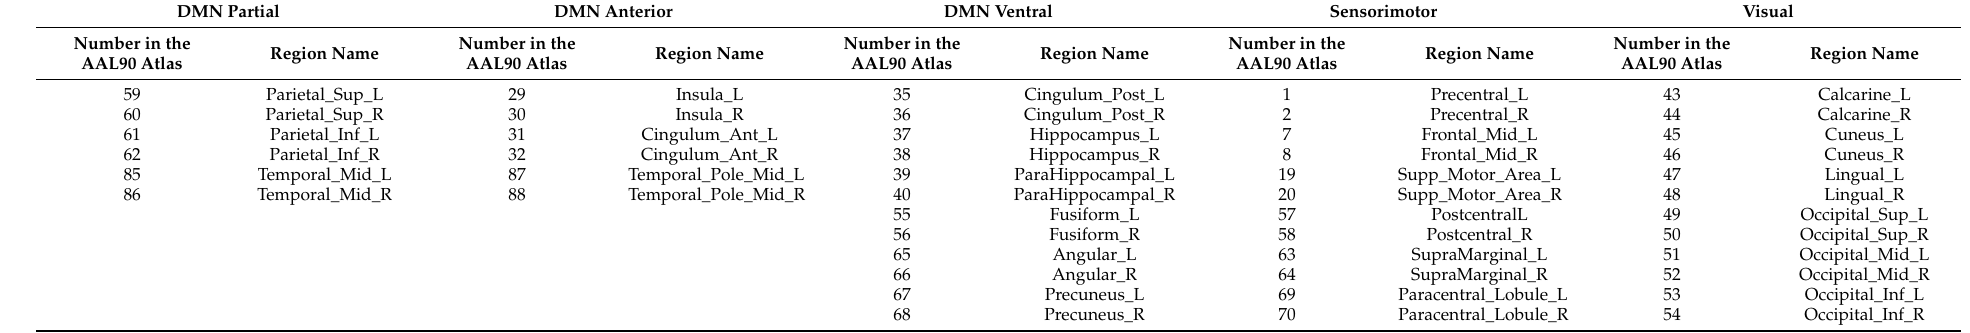
Table 1. Relationships of Regions of Interest (ROIs) for the construction of the Default Mode Network (DMN) and subnetworks considered according to the AAL90 atlas.